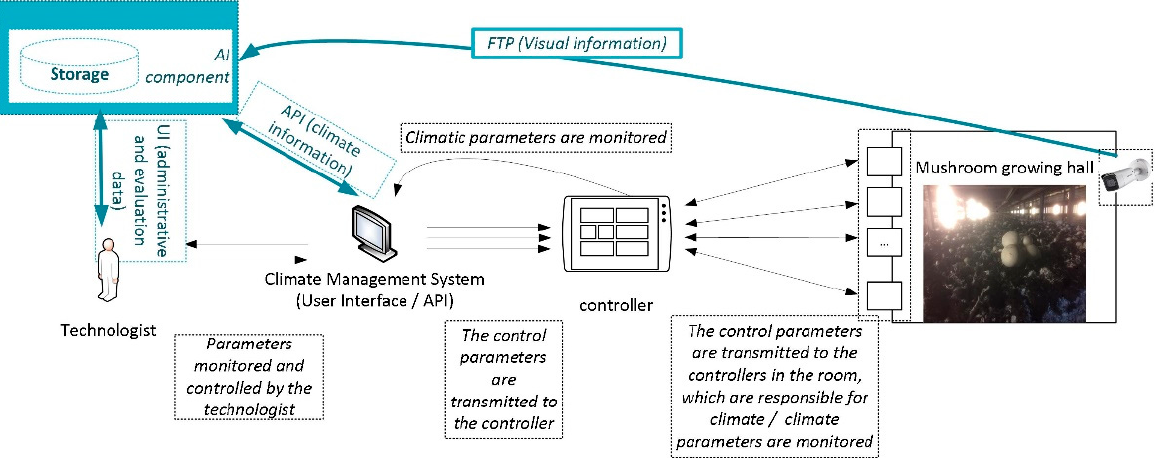
Figure 1. The architecture of the system. The components of the current climate management system (black) are extended with the AI-based components (blue). The arrows represent the data flow between the components.